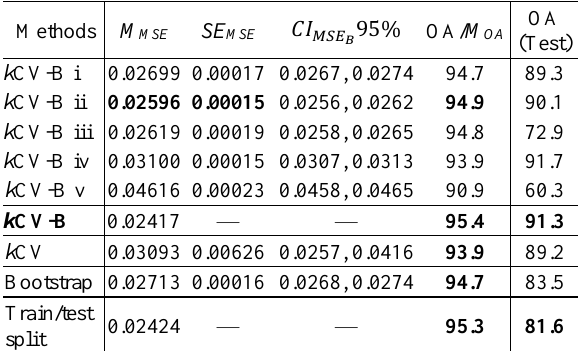
Table 3. Results of different methods for the validation data set from different folds and one test data set. k CV-B (.) mentions k CV-B method when (.)th fold is used for validation.